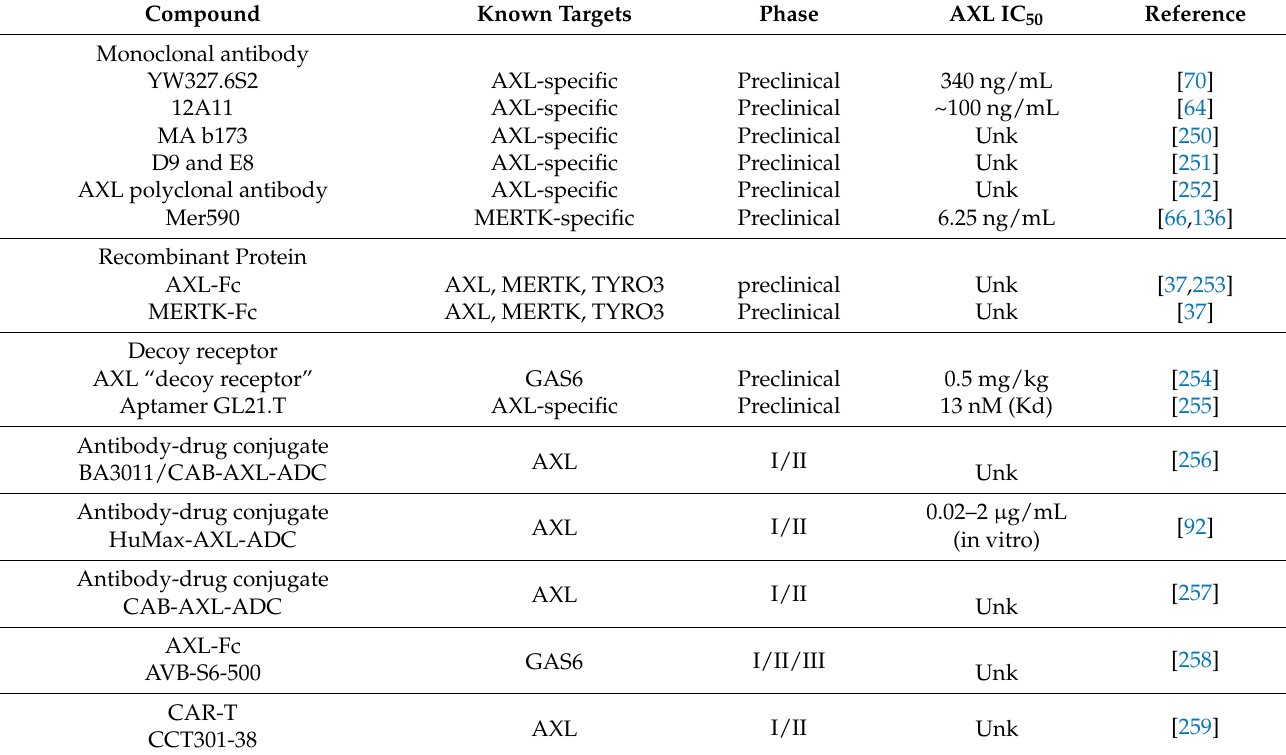
Table 2. Summary of biological agents for